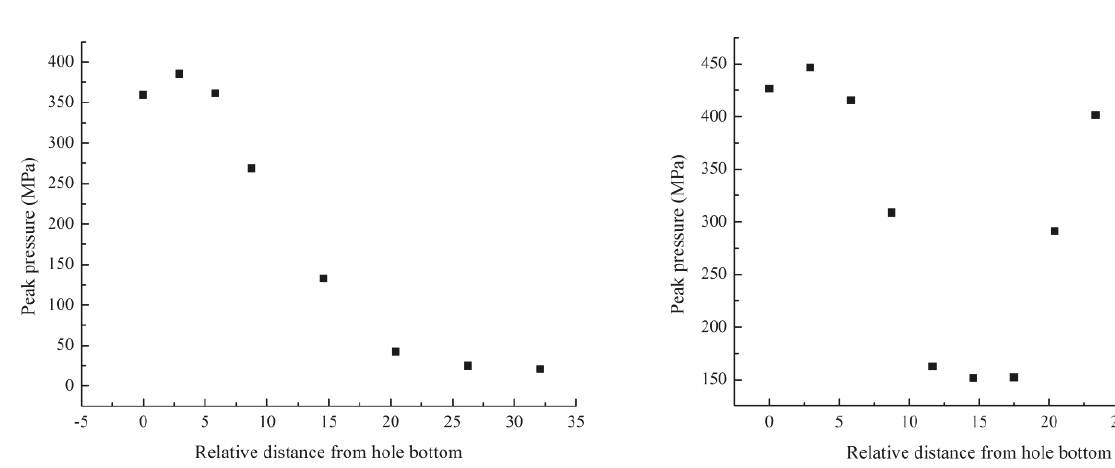
Figure 7: Variation in initial borehole wall pressure with relative distances from hole bottom (upper air-decked charging structure).